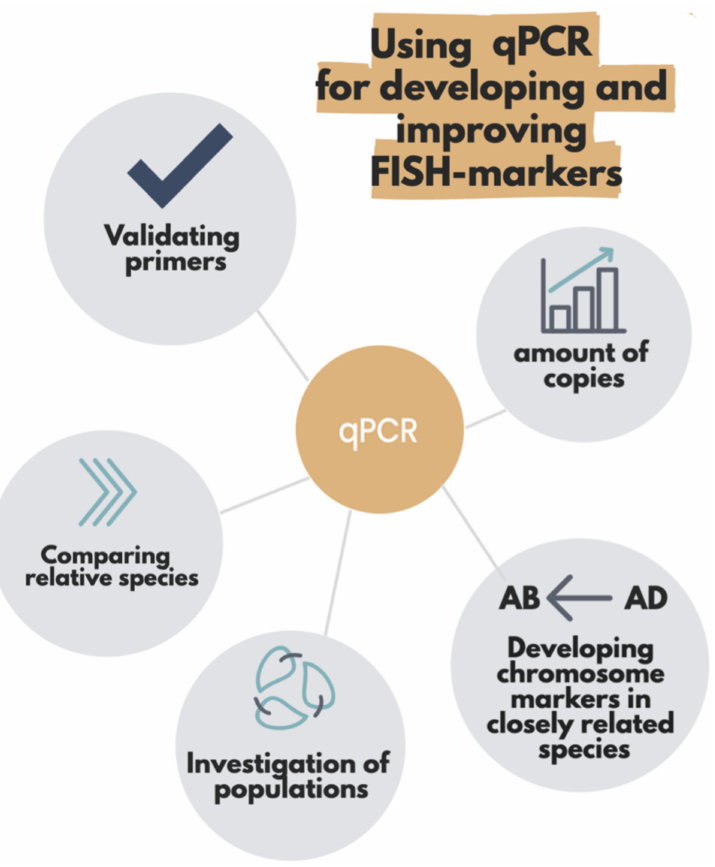
Figure 1. Methods of qPCR applied in different cases, including the development of FISH